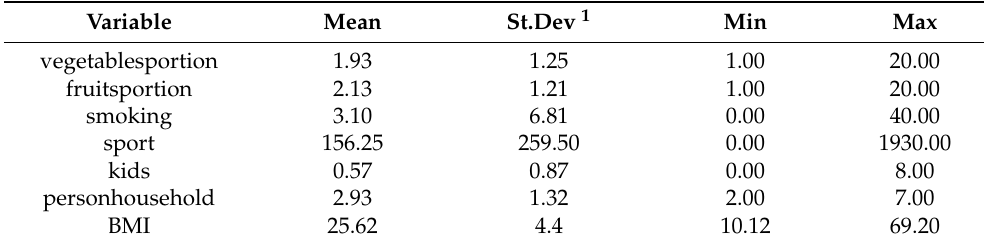
Table 2. Descriptive statistics for continuous variables.